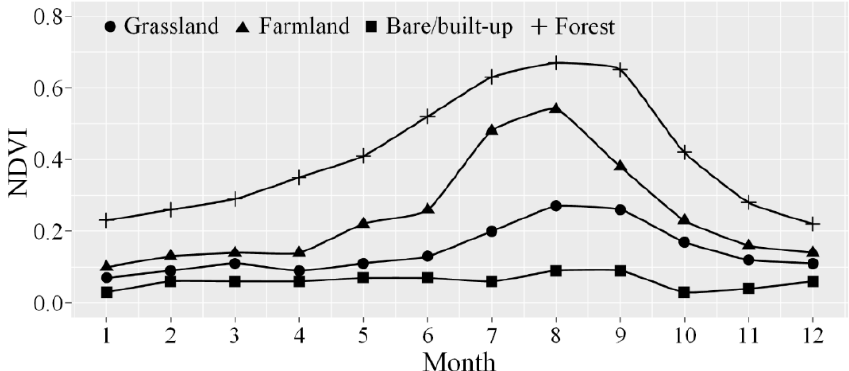
Figure 3. Temporal profiles for representative land cover Figure 3. temporal profiles for representative land cover types.